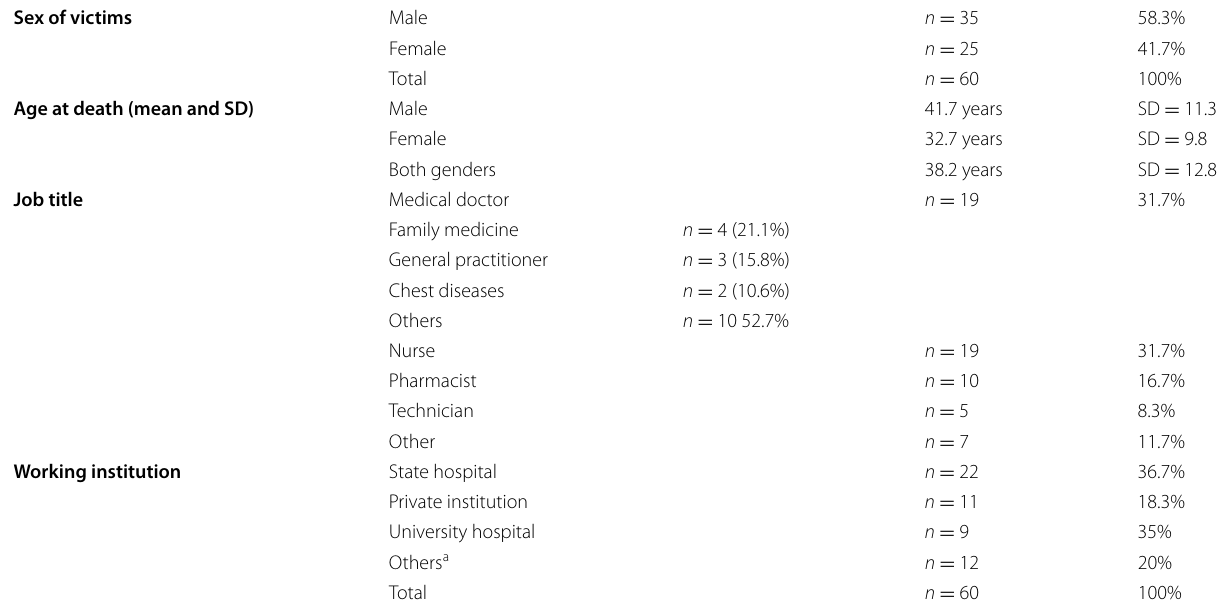
Table 1 Data about the sex, age, job, and working institution of the victims Sex of